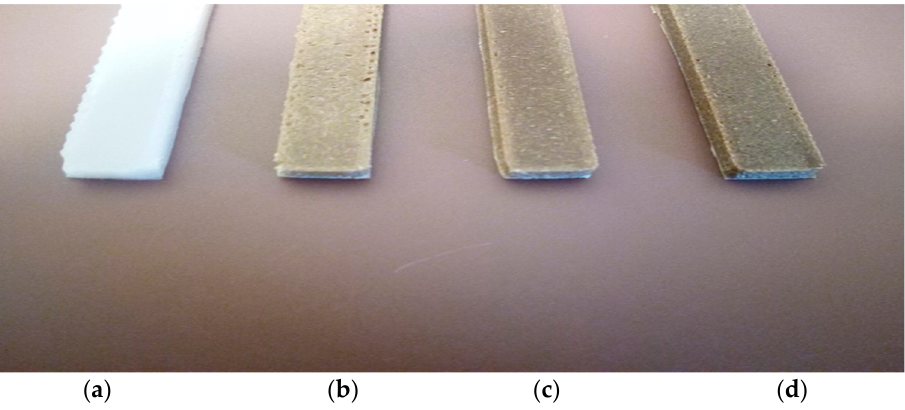
Figure 10. Charpy samples as a function of Typha fibre content. ( a ) PBSA, ( b ) PBSA/5 TT, ( c ) PBSA/10 TT, and ( d ) PBSA/15 TT.